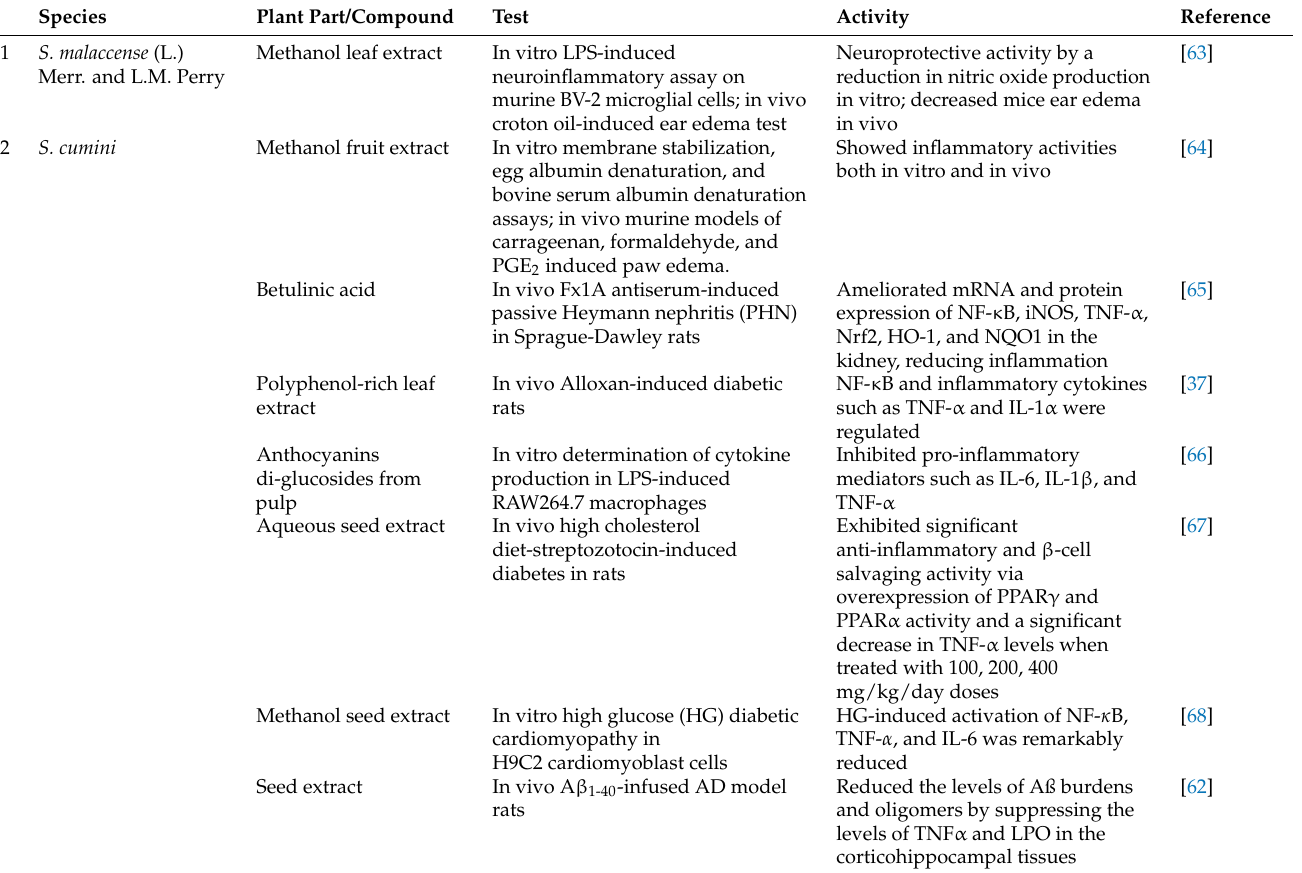
Table 2. Summary of anti-inflammatory activities reported from Syzygium